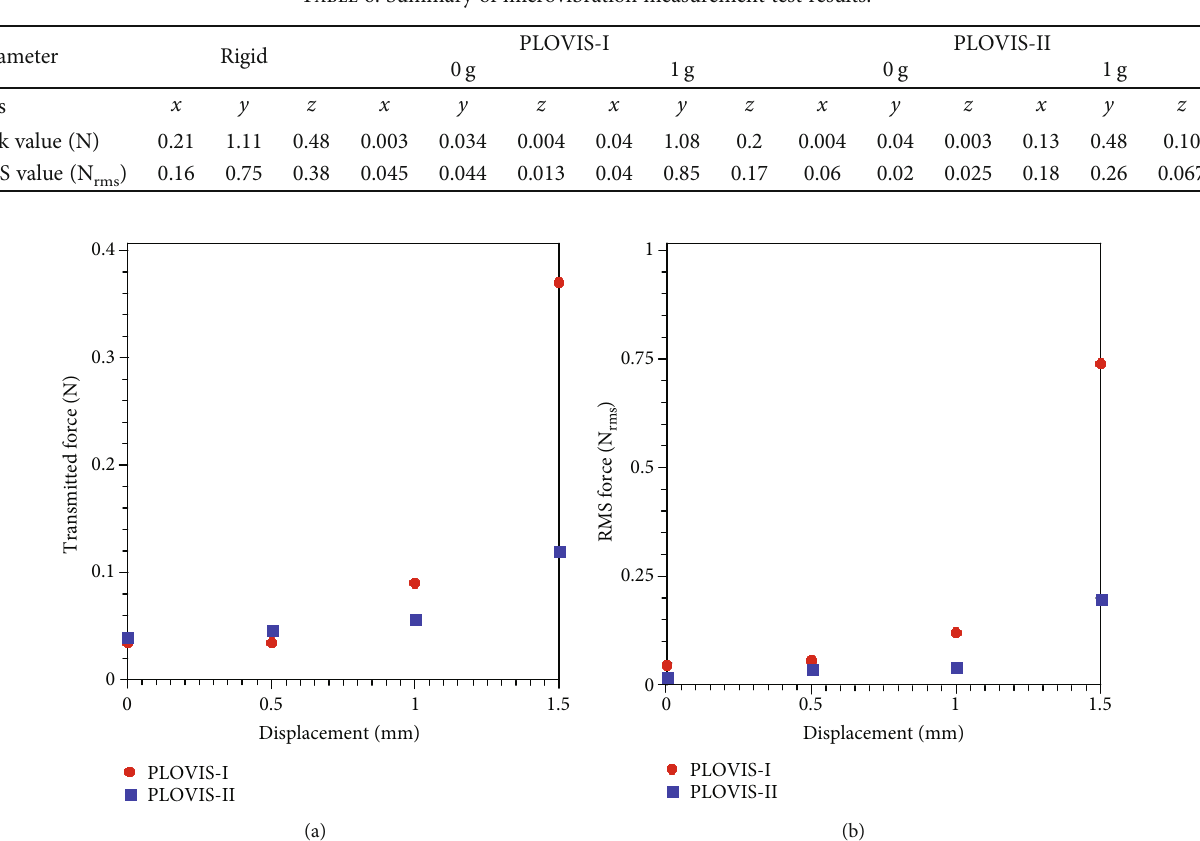
Table 6: Summary of microvibration measurement test results.